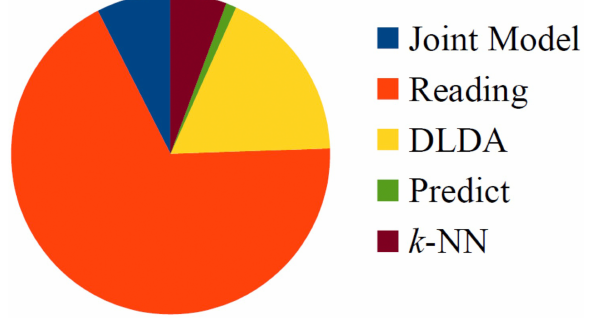
Figure 10. Computation load of proposed